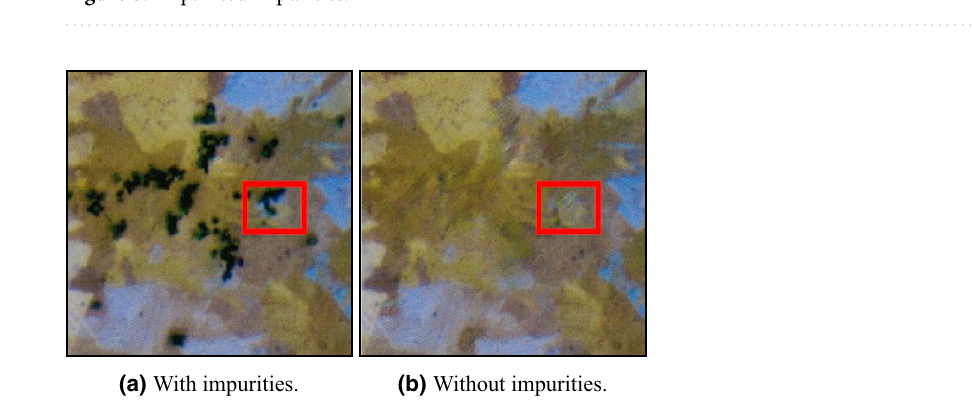
Figure 8. Inpainted impurities.